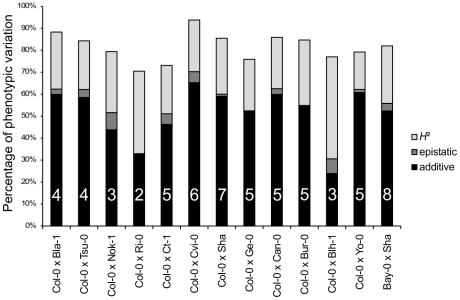
Broad-sense heritability, number of QTLs, and percentage of phenotypic variation explained by additive or epistatic QTLs for each of the 13 RIL families.
H
2: broad-sense heritability (light grey bars). The percentage of phenotypic variation explained by additive and epistatic QTLs is illustrated by black and dark grey bars, respectively. The number of additive QTLs is indicated on the black bars.